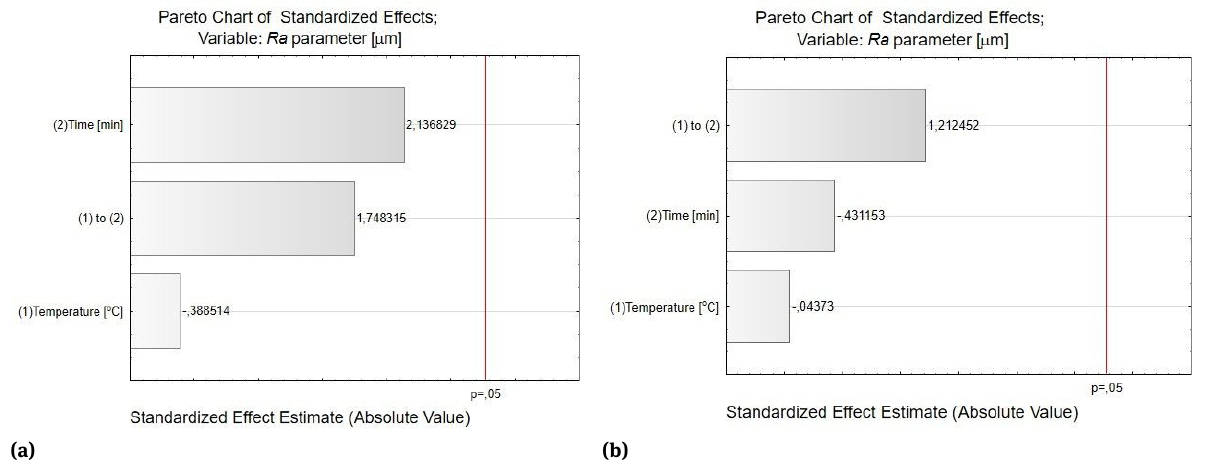
Figure 5: The Pareto chart of standardized effects for Ra surface roughness (a) before the tribological test, (b) after the tribological